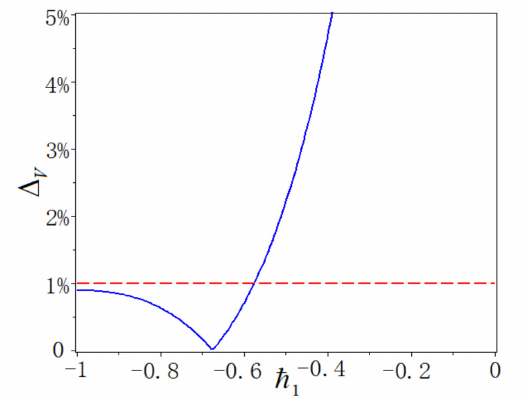
Figure 5. Relative errors curve ∆ V − h 1 of Equation (2.3b) when α = 2.0, ε 1 = 24 ( π − 2 ) / π 3